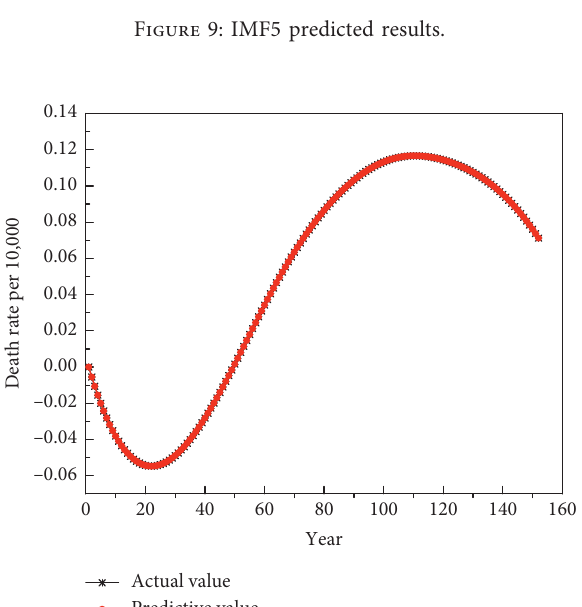
Figure 9: IMF5 predicted results.